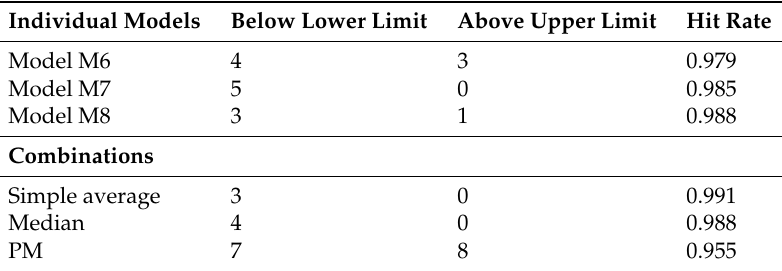
Table 8. Comparison of prediction